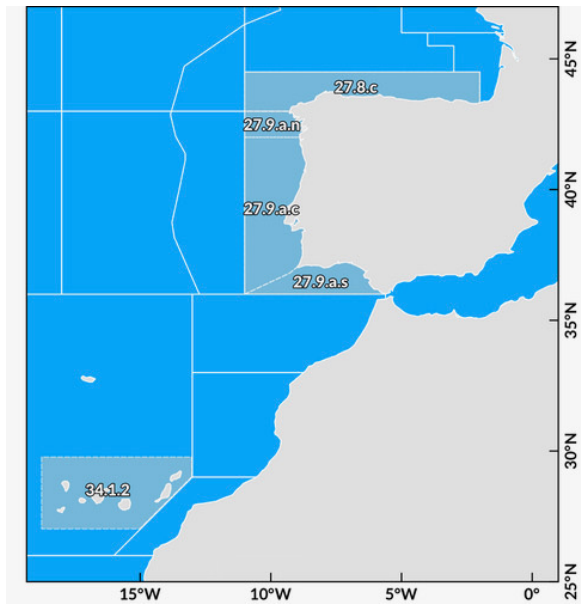
Fig. 1. – Map of the study area including the FAO subdivisions considered in the present analyses. 34.1.2, Canary Islands; 27.9.a.s, Gulf of Cadiz; 27.9.a.c, W Portuguese coast; 27.9.a.n, NW Spanish coast; 27.8.c., Cantabrian